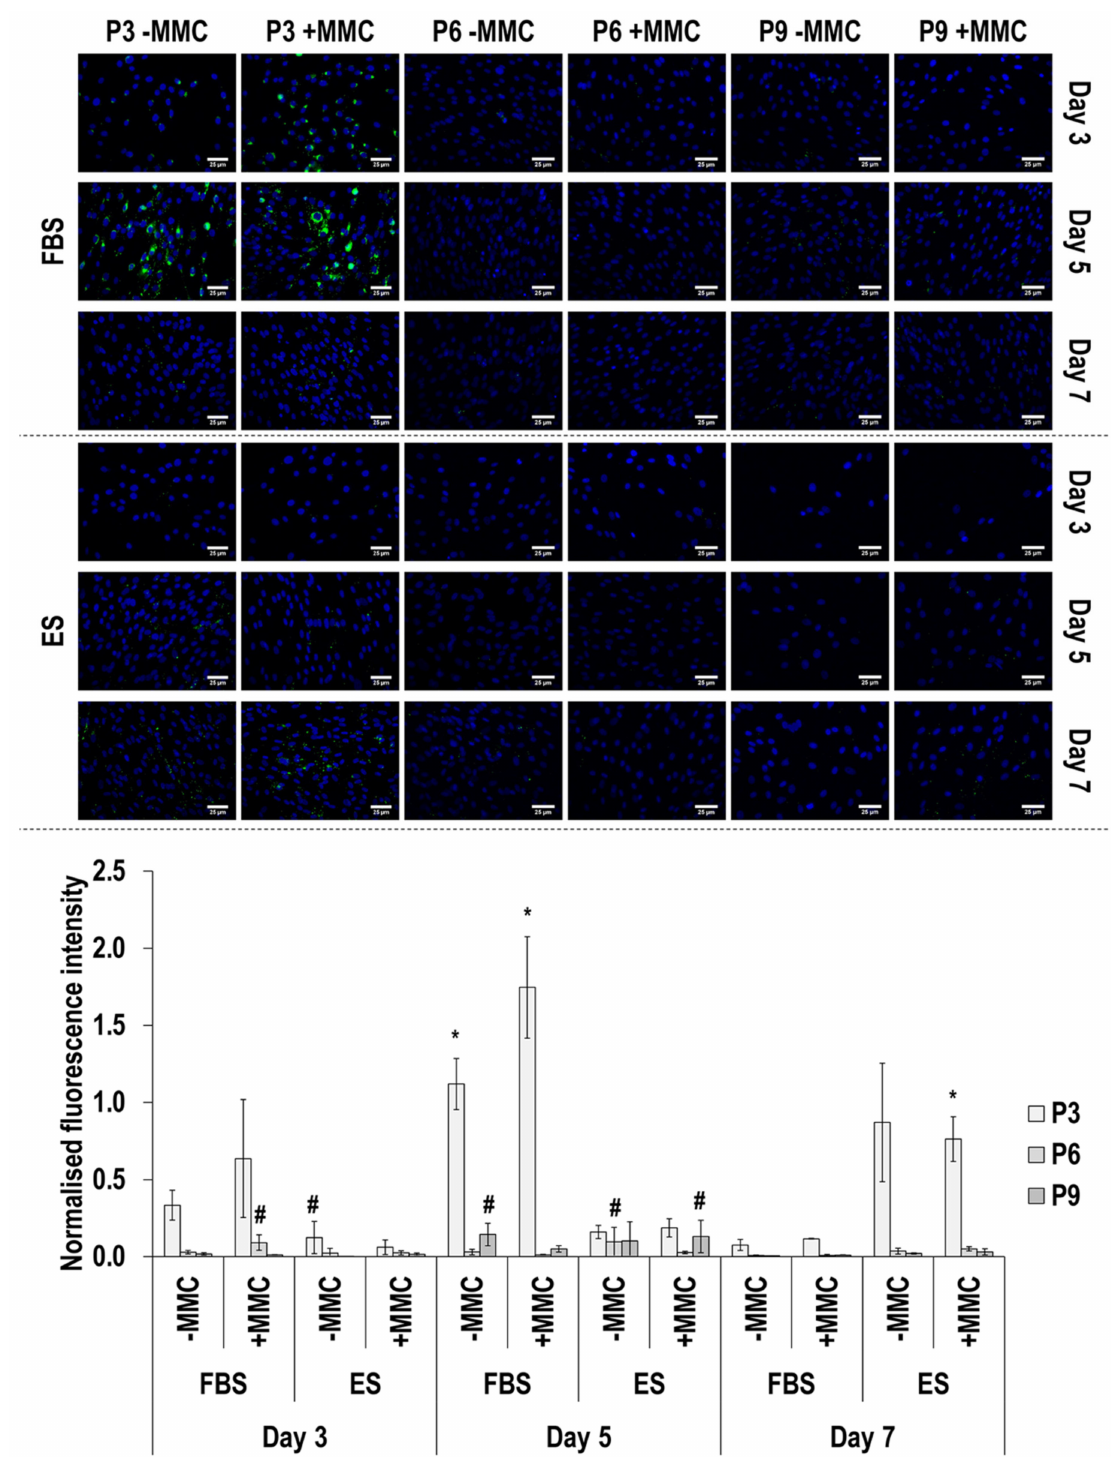
Figure 9. Immunofluorescence and image intensity analysis for connexin 43 as a function of serum, passage, MMC and time in culture. Fluorescence intensity was normalised to cell number. * indicates a significant ( p < 0.05) increase in comparison to cells at passage 3, day 3, in FBS and without MMC. # indicates a significant ( p < 0.05) decrease in comparison to cells at passage 3, day 3, in FBS and without MMC. Scale bar: 25 µ